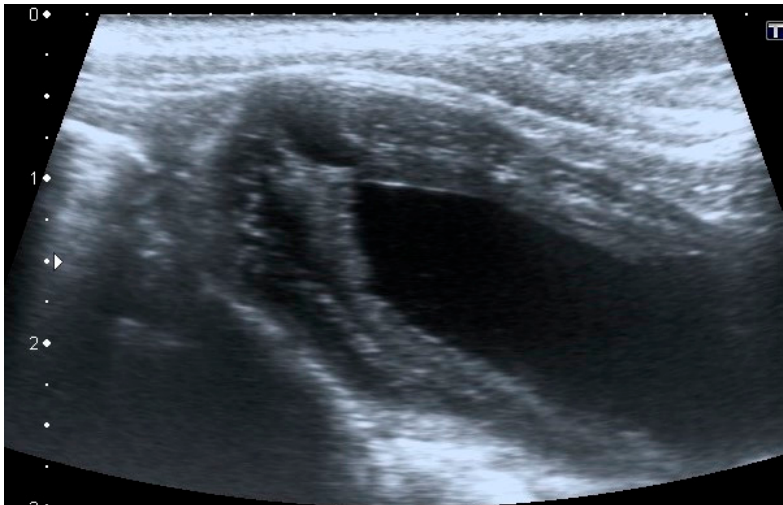
Figure 2. Longitudinal ultrasound image of the urinary bladder in a dog, showing the presence of a small ( < 1 cm diameter), well-defined, fluid-filled, anechoic structure in the cranioventral bladder wall, consistent with intramural vesicourachal diverticulum.